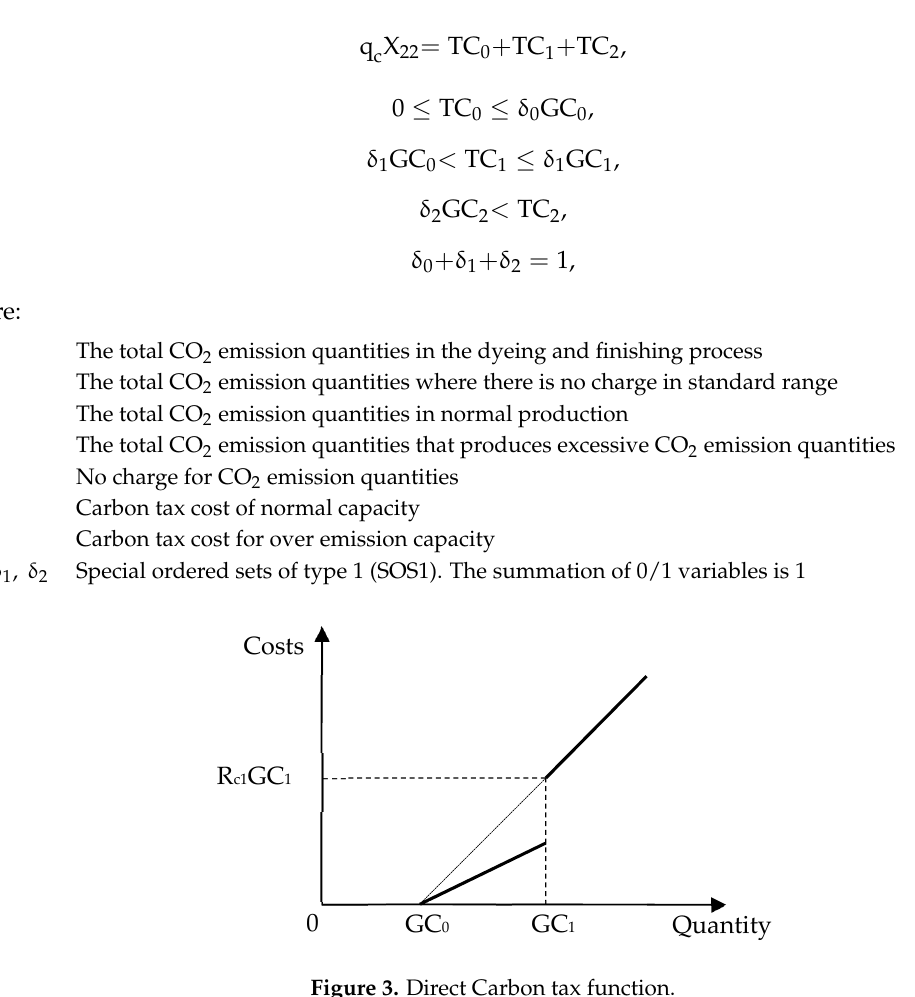
Figure 3. Direct Carbon tax function.